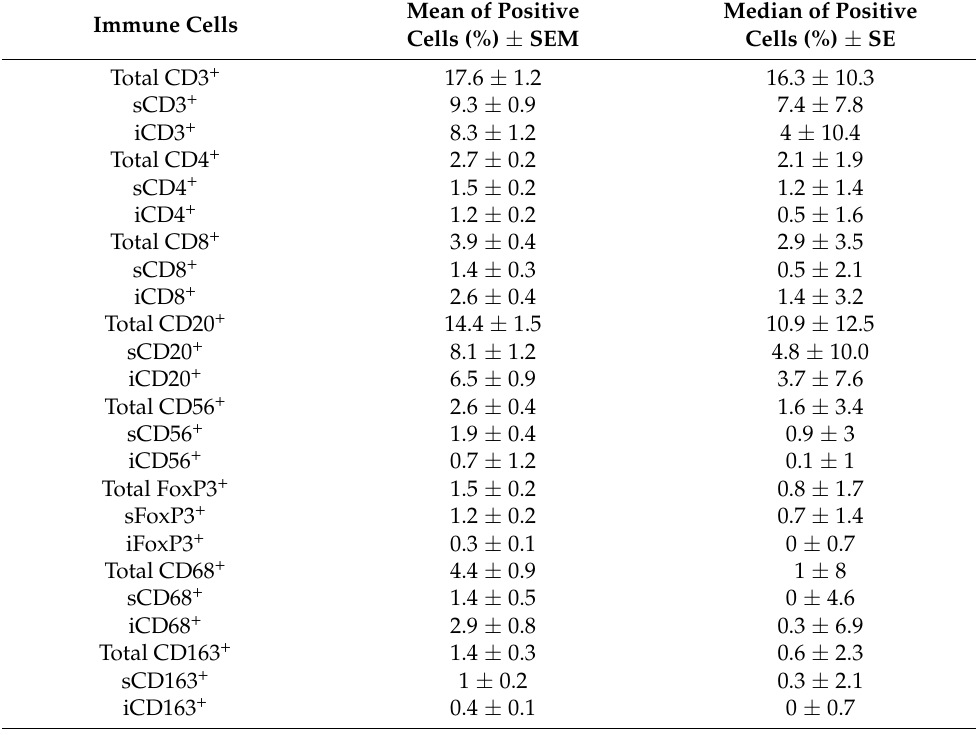
Table 2. The mean ± standard error of the mean (SEM) and median ± standard deviation (SE) percentages of positive immune cells in the 73 tumors evaluated, according to their tumor location [total, stromal (s) and intratumoral (i)]. Immune